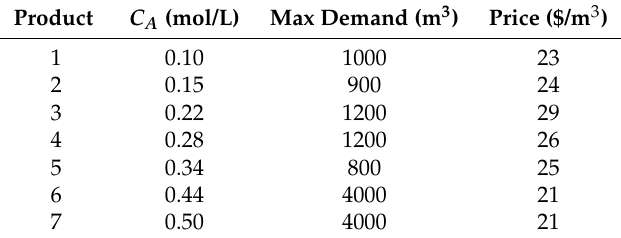
Table 17. Additional scenario: Product specifications.